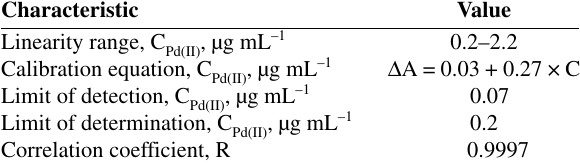
Table 1. The metrological characteristics of spectrophotometric de- termination of the Pd(II) with ITHBA (C(ITHBA) =